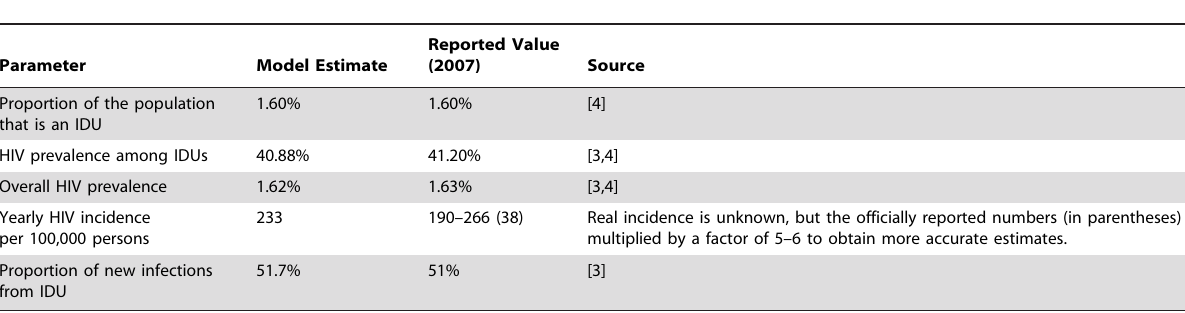
Table 4. Model calibration, validation parameters, and